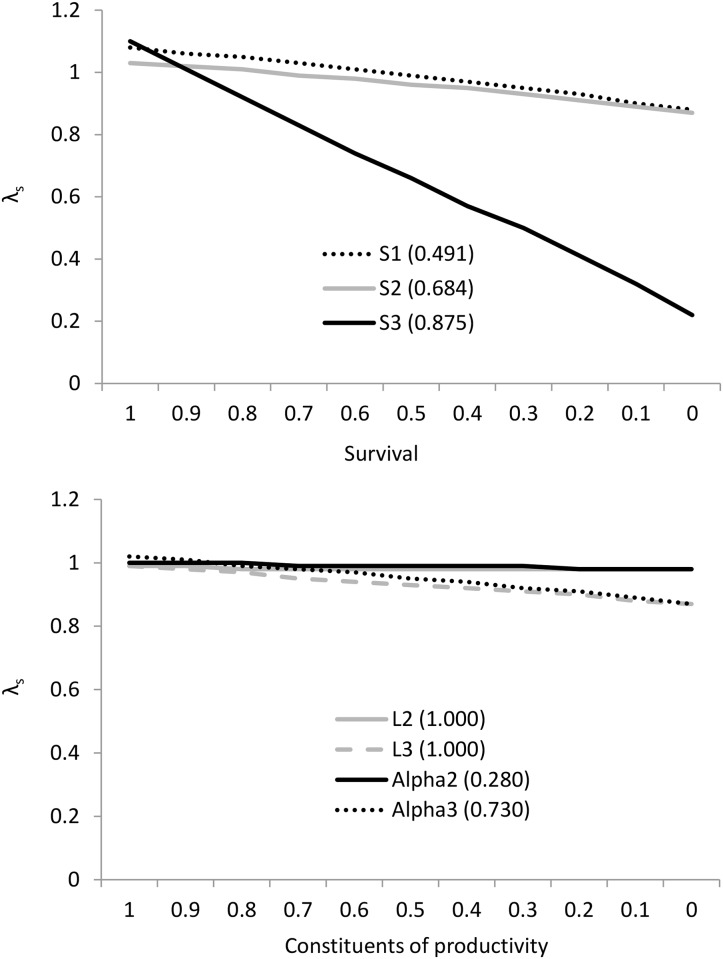
Effects of changing age-specific annual survival rates (top) and the constituents of productivity (bottom) on the population growth rate of Myotis nattereri.The vital rates used are shown in brackets. In the absence of perturbation, the mean stochastic growth rate λs was 0.986 i.e. a slow decline but close to stable.